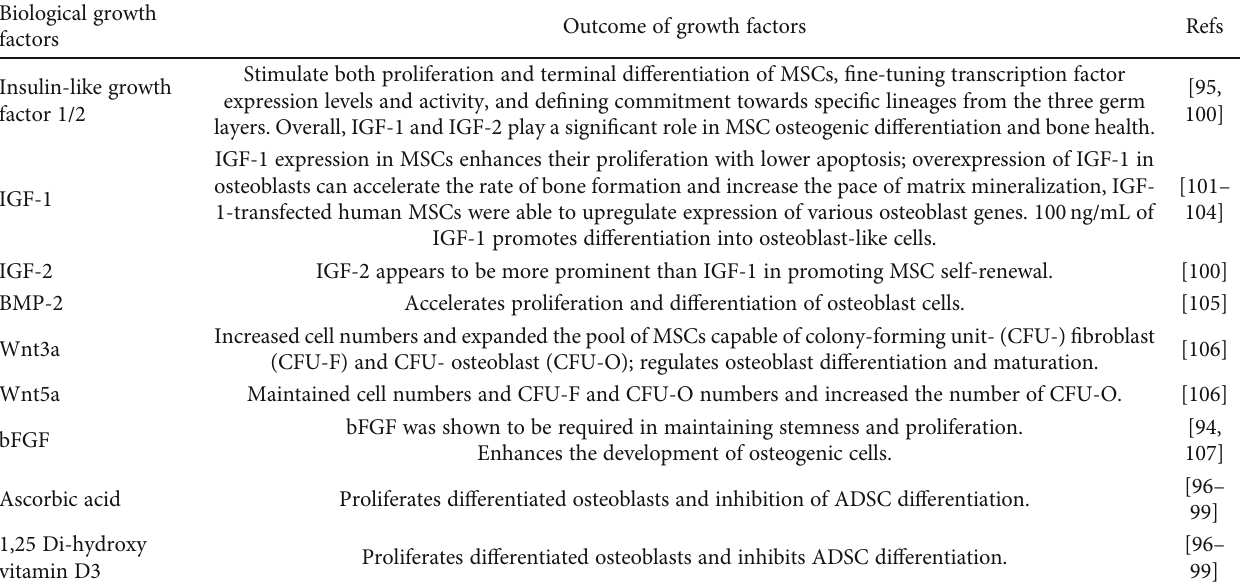
Table 1: Biological growth factors introduced to ADSCs for osteogenic di ff erentiation.